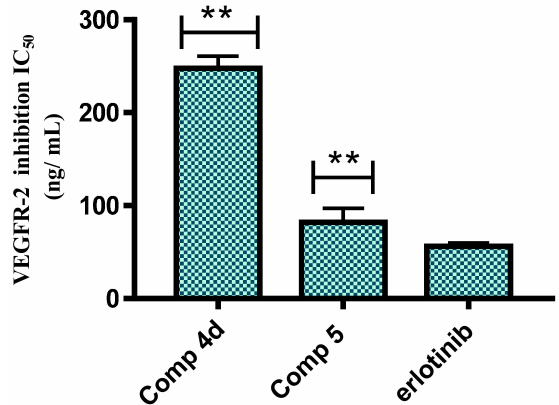
Figure 4. A graphical representation of the IC 50 values (ng/mL) of compounds 4d , 5, and erlotinib for the VEGFR-2 enzyme. Data are expressed as the mean ( n = 3 experiments) ± SEM and statistical comparisons were carried out using one-way analysis of variance (ANOVA) followed by Tukey’s multiple comparisons test (**, p < 0.05).